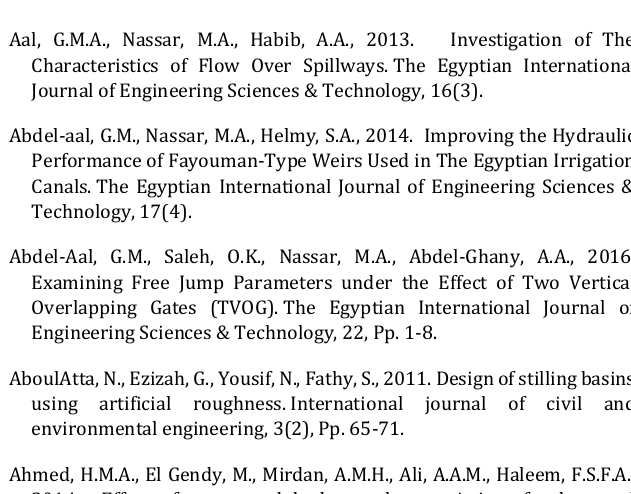
Figure 33: The relationship between the residuals’ values versus the statistical validating comparative length of the free H. jump